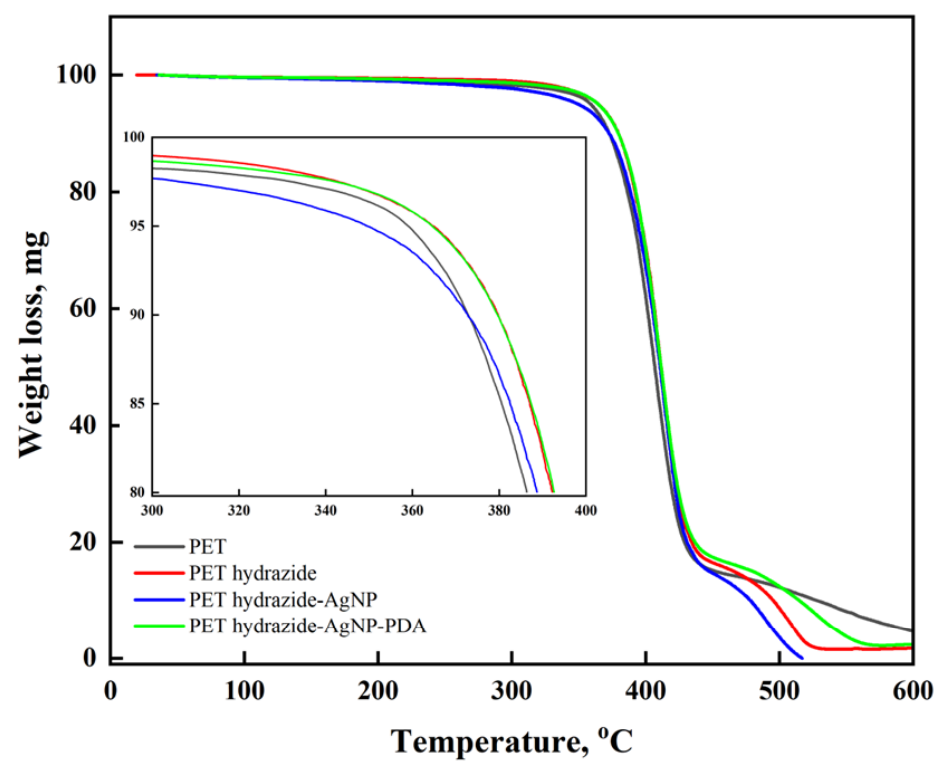
Figure 5. Low and high magnification thermograms of PET, PET hydrazide, PET hydrazide-AgNP, and PET